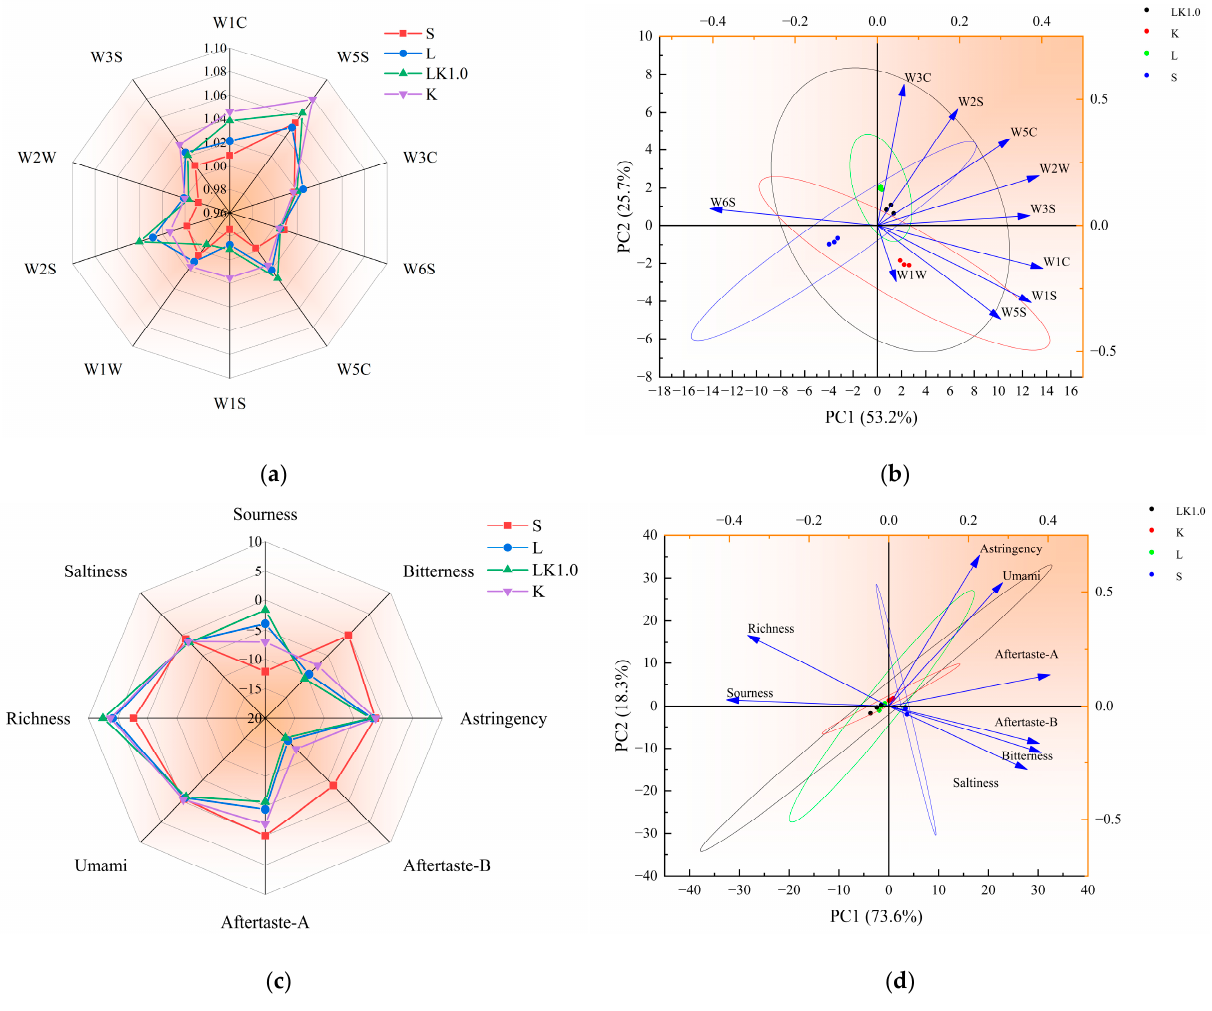
( e ) Figure 6. ( a ) Electronic nose radar diagram. ( b ) Principal components for the electronic nose data. ( c ) Electronic tongue radar diagram. ( d ) Principal components for the electronic tongue. ( e ) Corre- lations among the microbes, smell, and taste.